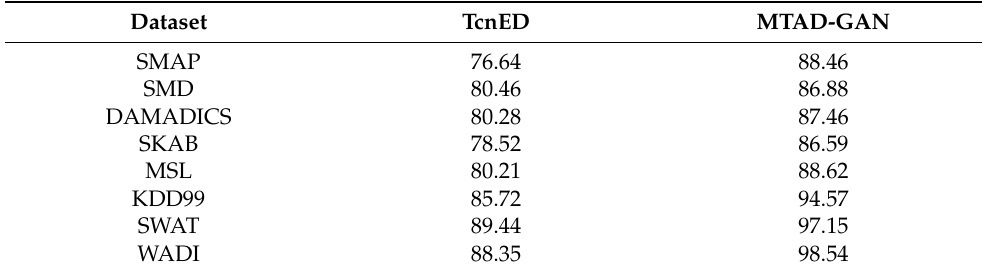
Figure 6. AUCROC comparison of each model method. Table 6. Performance comparison of the accuracy of different